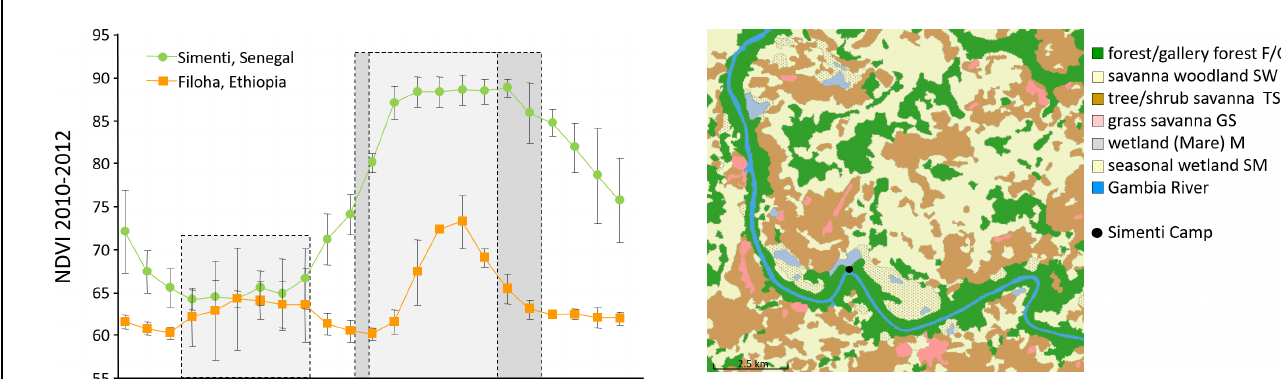
Figure 4. Distribution of habitat classes within the area of interest around CRP Simenti. The black dot indicates the position of the field station of the Centre de Recherche de Primatologie (CRP). We defined the area of interest as the total extent of monitored baboon occurrences in